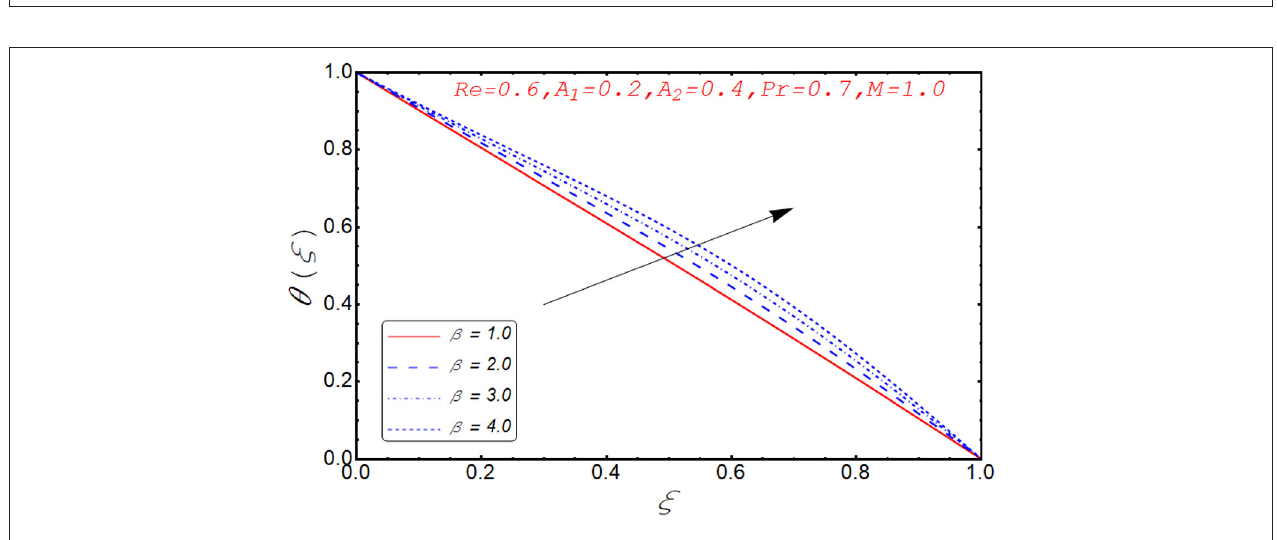
FIGURE 14 | Behavior of θ ( ξ ) for different β